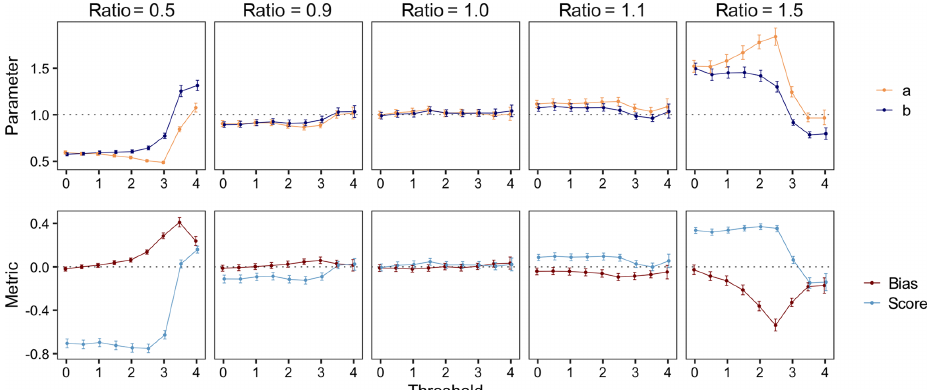
Figure D2. As Fig. 5 but ensemble fields are constructed with skill parameter ρ = ω =